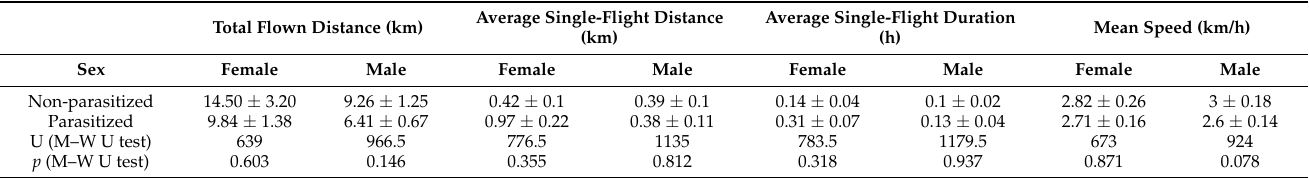
Table A2. Comparison of flight performance parameters between different parasitism statuses of Sirex noctilio